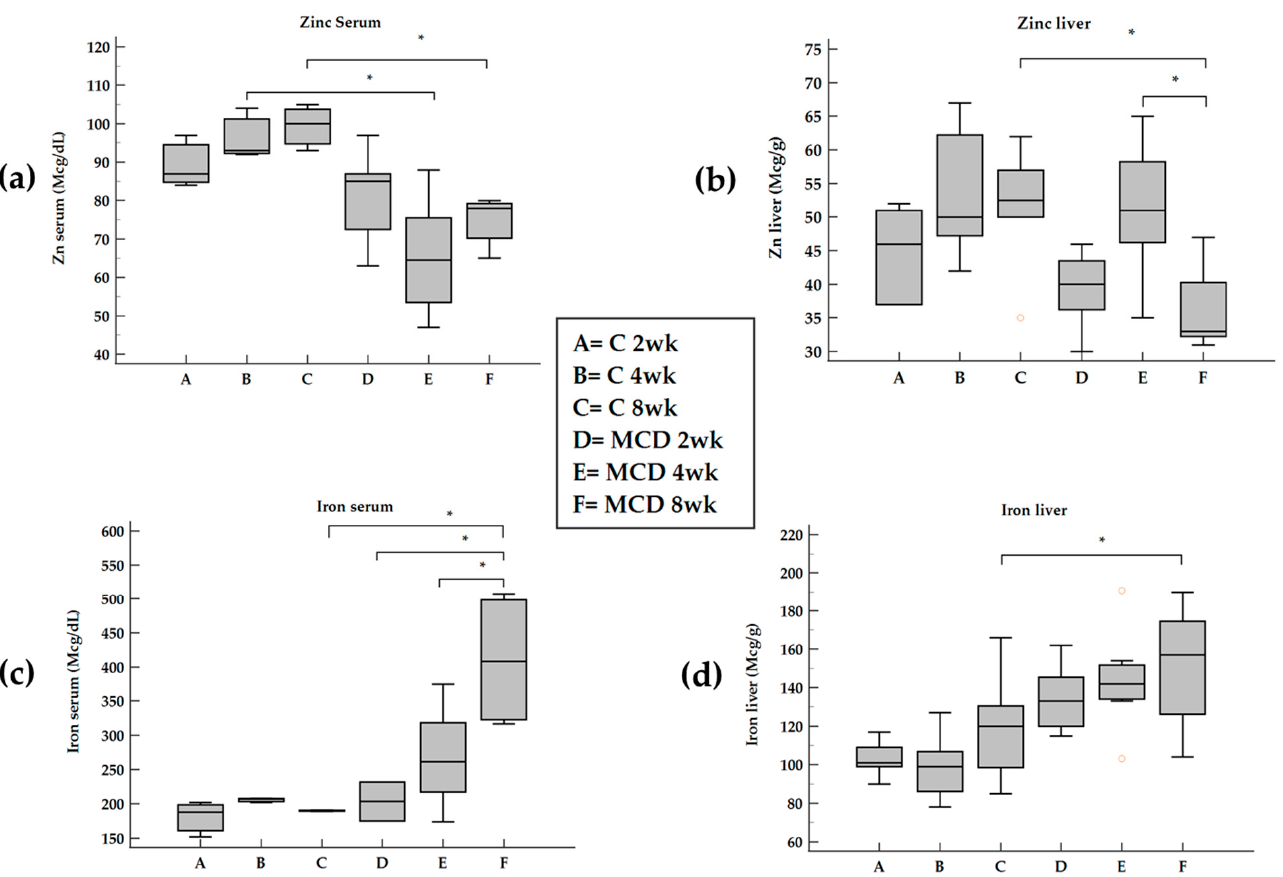
Figure 2. Changes in serum and tissue Zn and Fe in rats fed with MCD diet. Panel ( a ) and panel ( b ), serum and liver Zn; panel ( c ) and panel ( d ), serum and liver Fe; weeks (wk). * p ≤ 0.05. The levels of serum Fe increased after an 8-week MCD diet and the same trend occurred for hepatic Fe (Figure